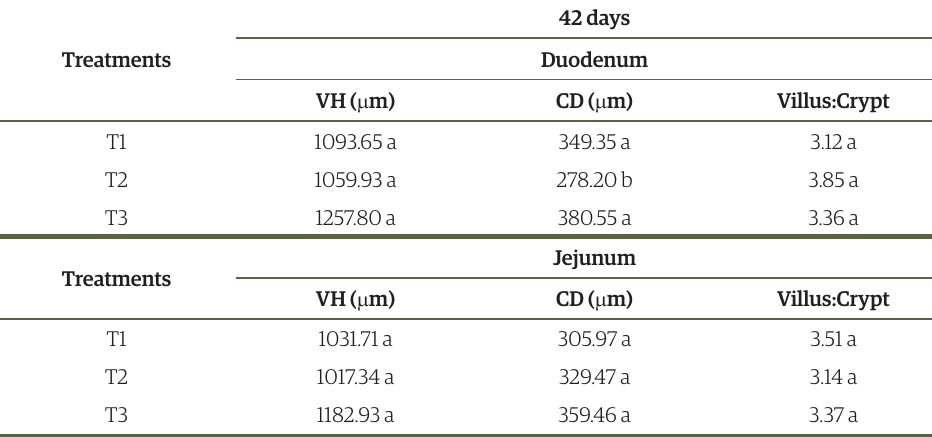
Table 2. Mean villus height (VH), crypt depth (PC), and Villus:Crypt ratio of the duodenum and jejunum in 42-day-old chickens receiving diets with or without